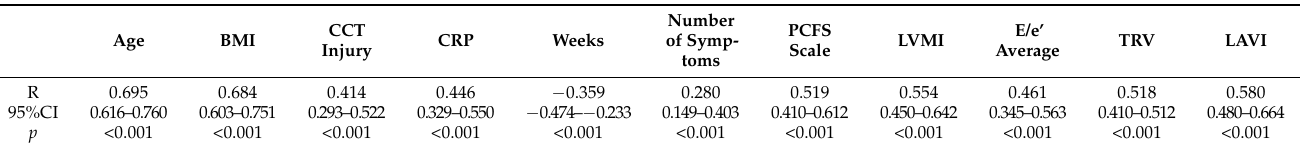
Table 4. Correlations between the number of MS elements with clinical and other TTE parameters and laboratory data for the study patients.